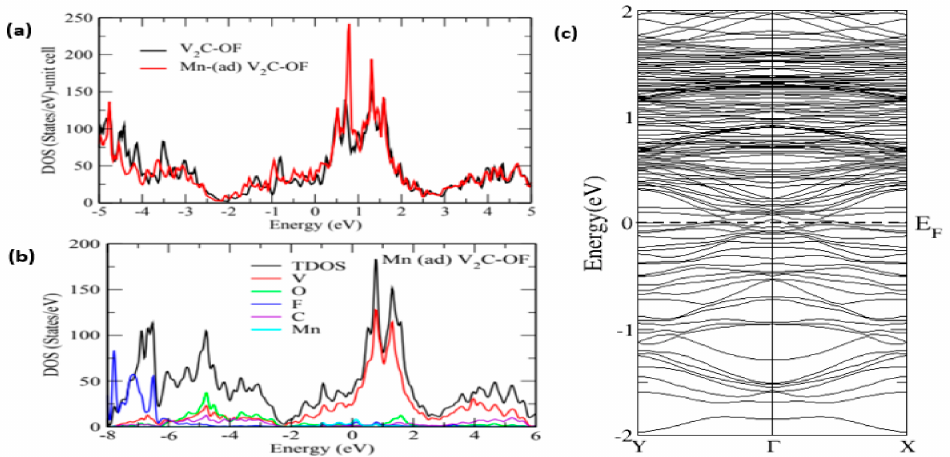
Figure 4. ( a ) DOS vs. energy V 2 C-OF and Mn-adsorbed V 2 C-OF, ( b ) total DOS vs. energy V 2 C-OF and Mn-adsorbed V 2 C-OF, ( c ) electronic bandgap structure for Mn-adsorbed V 2